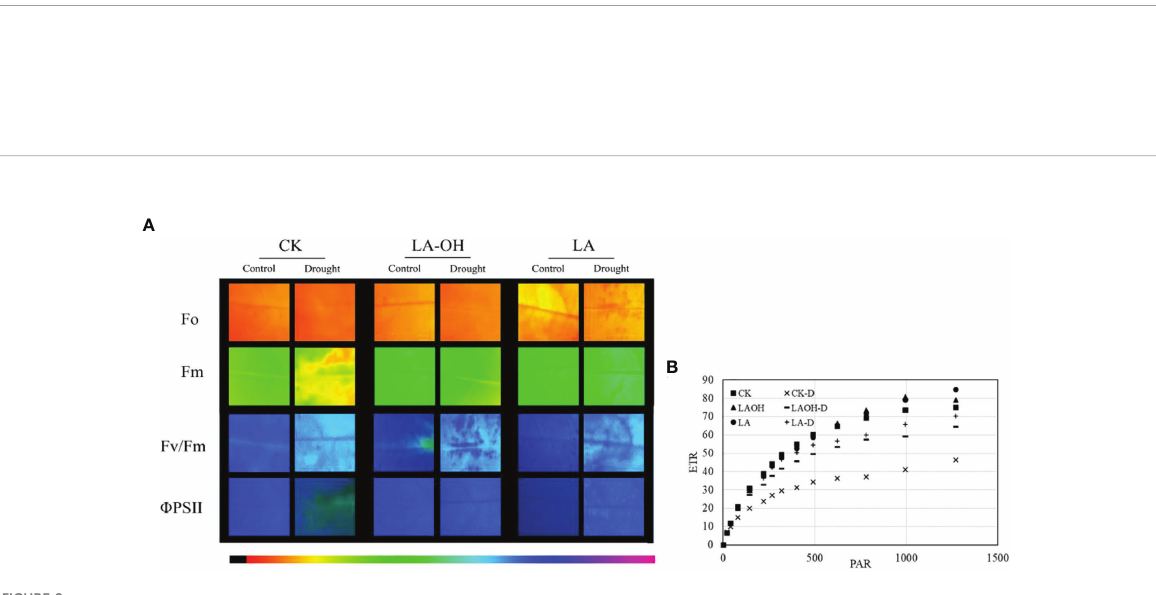
FIGURE 8 Chlorophyll fl uorescence parameters in leaves of the peach seedings. (A) Chlorophyll fl uo-rescence imaging of F0, Fm, Fv/Fm and F PSII; The darker the color, the greater the Fv/Fm; (B)